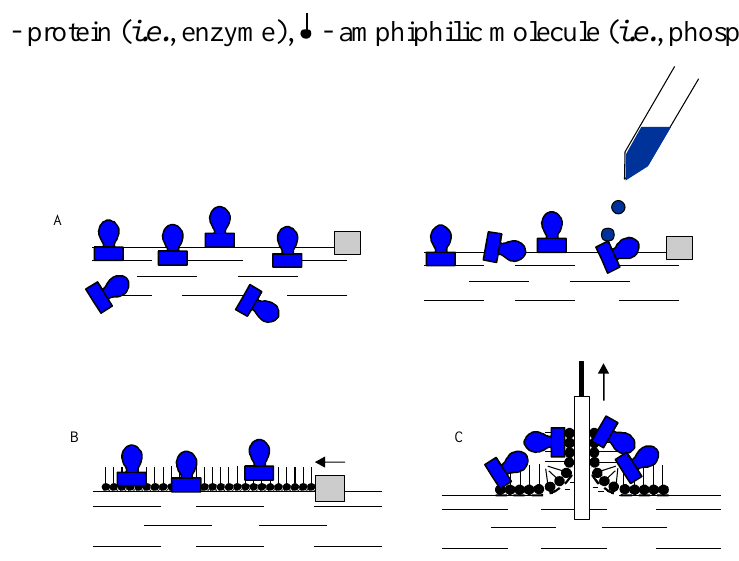
Figure 1. Three approaches to form enzyme mononlayers through Langmuir and LB technique;